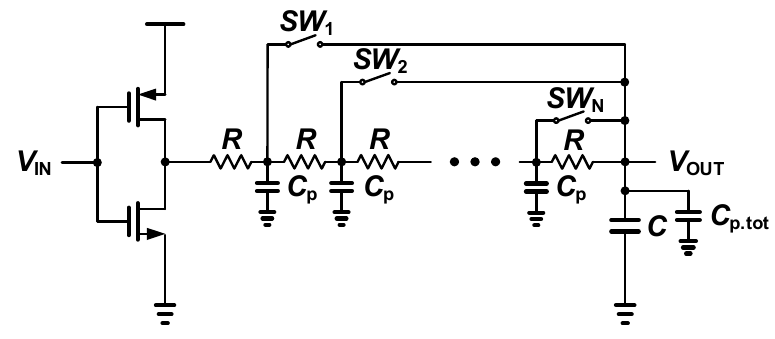
Figure 3. Proposed resistive controlled delay cell.